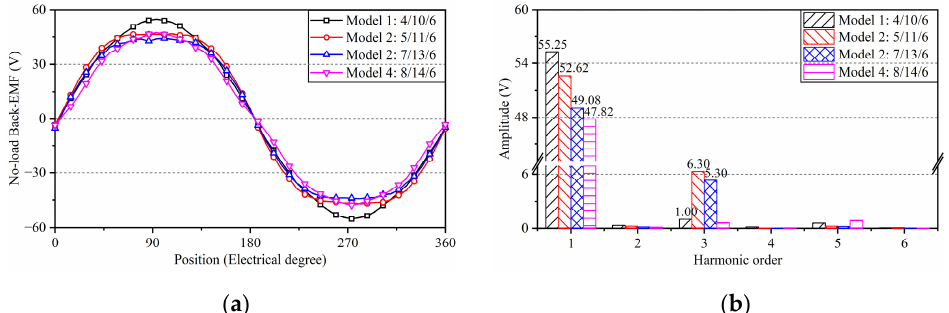
Figure 8. The no ‐ load back ‐ EMF ( a ) and harmonic order ( b ) of DCB ‐ VRLMs with different combinations.